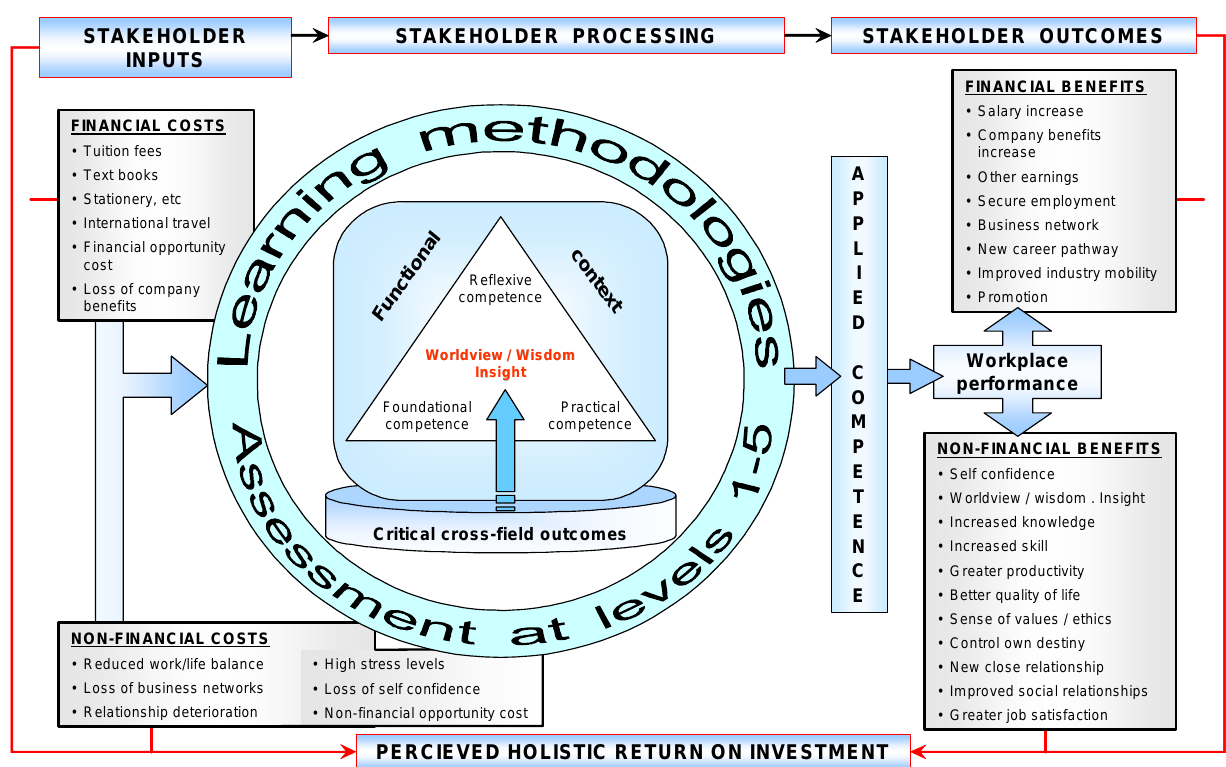
Figure 8: A holistic framework for the perceived return on investment in an MBA The circle represents the role and activities of faculty and learning facilitators in ‘processing’ the student. This processing activity includes the learning